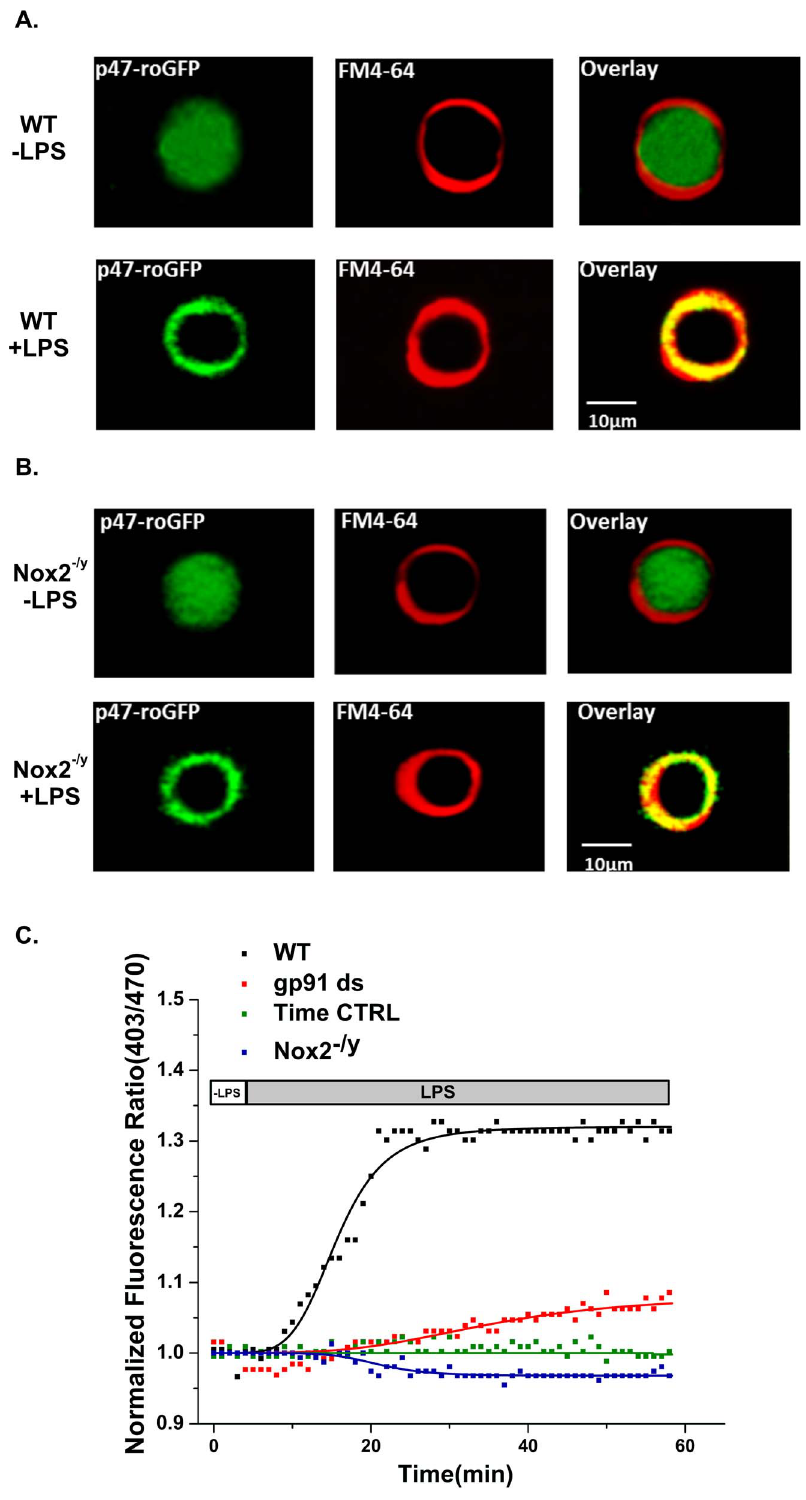
Figure 4. p47-roGFP biosensor shows specificity to the Nox complex in primary spleen macrophages. (A) Macrophage cells from wild- type mice (C57Bl/6j) expressing transiently transfected p47-roGFP showed homogeneous cytosolic distribution of p47-roGFP in the absence of LPS- mediated activation ( 2 LPS). Upon LPS-mediated activation p47-roGFP localized with the membrane dye FM4-64 H ( + LPS). (B) In the absence of LPS ( 2 LPS), p47-roGFP is distributed homogeneously throughout the cytosol of macrophages isolated from Nox2 deficient (Nox2 2 /y ) mice. Upon LPS stimulation ( + LPS), p47-roGFP translocated to the cell membrane of Nox2 2 /y macrophages, localizing with FM4-64 H . (C) LPS stimulation of primary spleen macrophages resulted in rapid oxidation of p47-roGFP in wild-type macrophages (black squares). Cells incubated with gp91ds (5 m M, 60 min.) demonstrated a significant reduction in the rate and extent of p47-roGFP oxidation (red squares). In Nox2 2 /y macrophages (blue squares) LPS did not